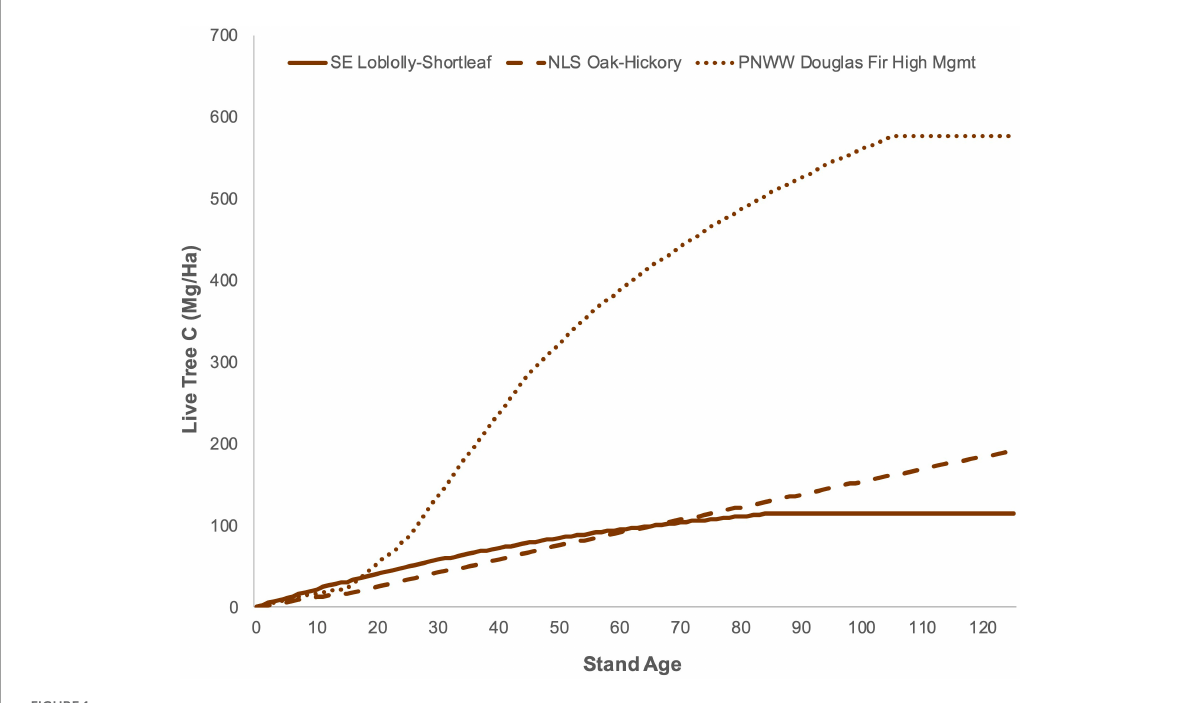
FIGURE1 Cumulative live tree carbon accumulation by stand age in assessed forest types.